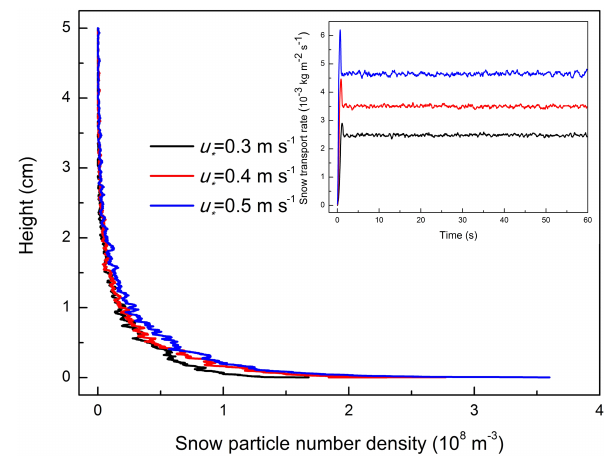
Figure 1. Temporal evolution of snow transport rate (the inset fig- ure) and the profile of snow particle number density at the steady state for three wind force